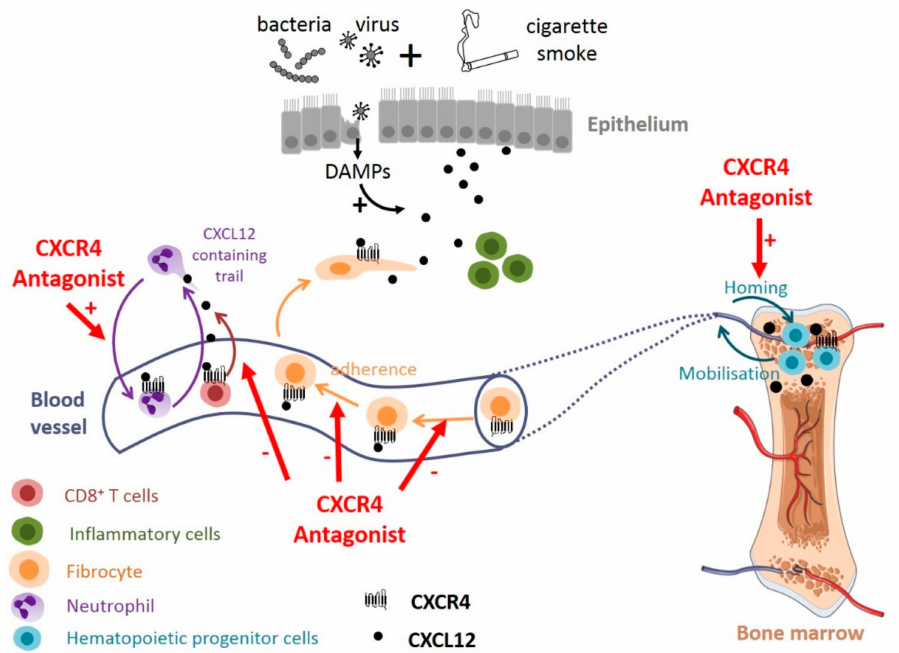
Figure 3. Potential e ff ect of targeting CXCL12 / CXCR4 axis in COPD. CXCR4 antagonists might act at various levels in COPD: they could promote neutrophil demargination from the lungs and inhibit T-cells and fibrocytes recruitment into bronchial tissue. CXCR4 antagonists may also contribute to maintaining the pool of hematopoeitic progenitor cells in the bone marrow, available for tissue repair. DAMPs: damage-associated molecular